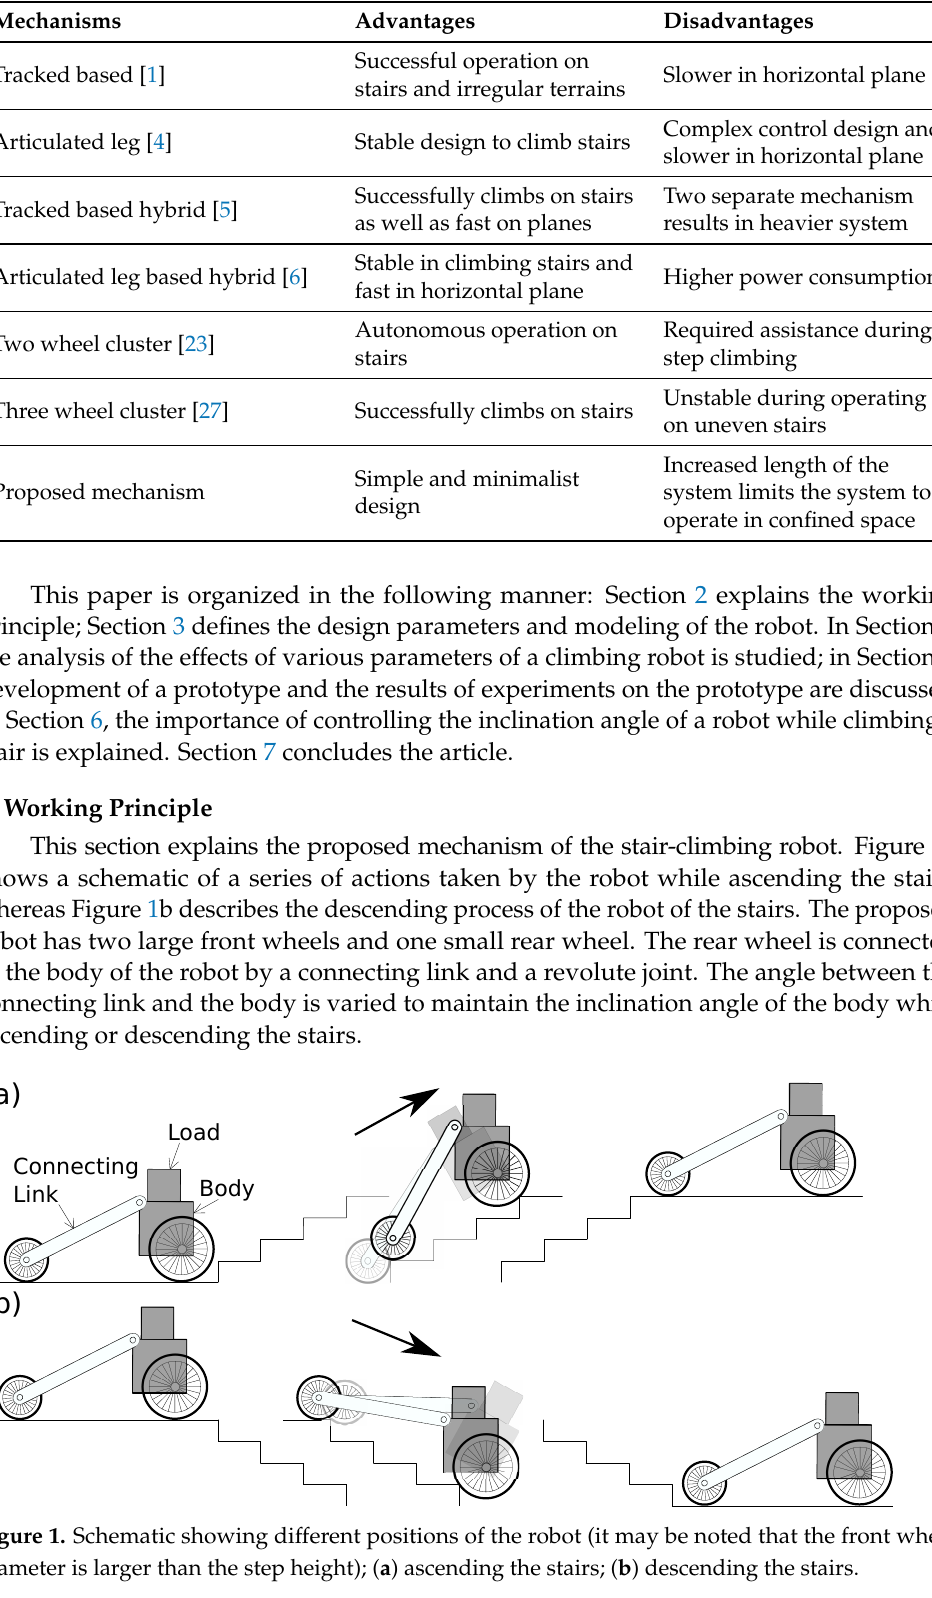
Table 1. Qualitative comparison of existing step climbing mechanism.